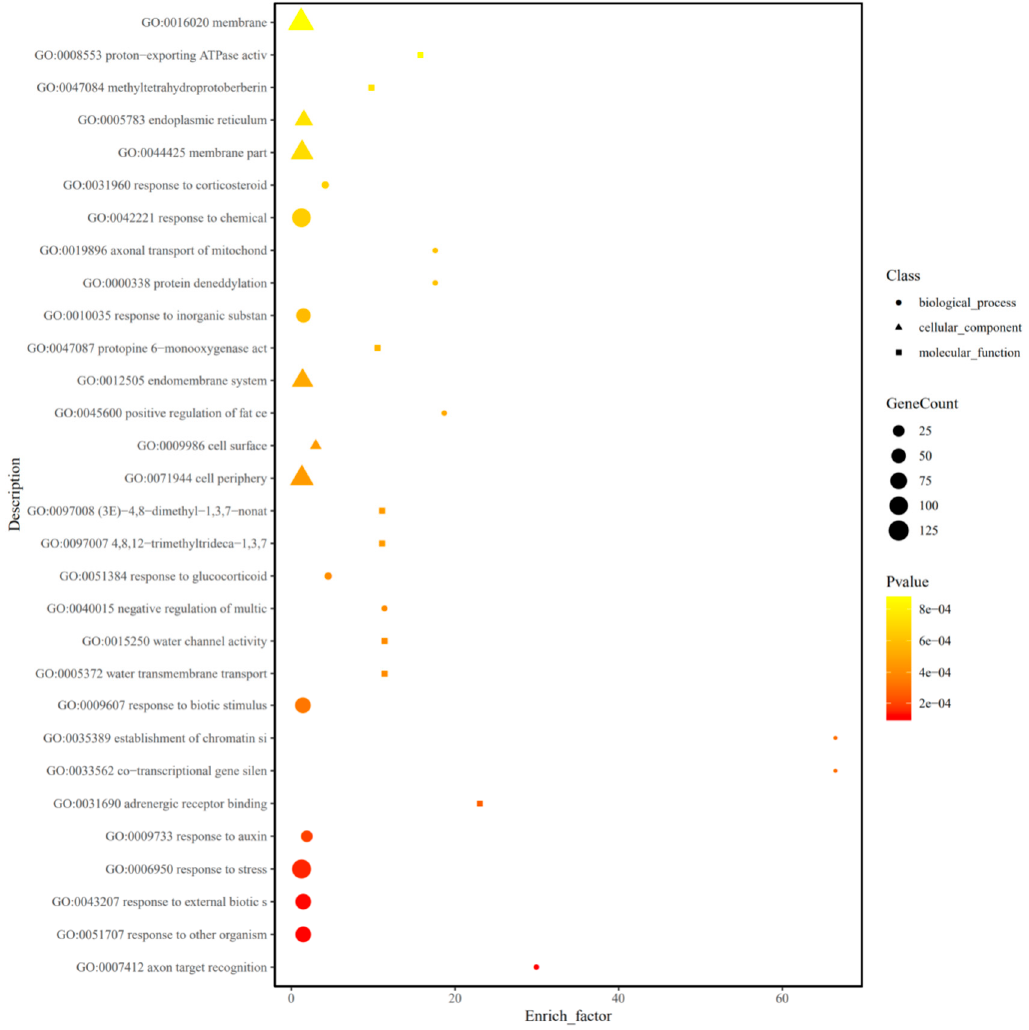
Figure 8. Gene ontology (GO) enrichment analysis on target genes of di ff erentially expressed lncRNAs under boron deficiency stress. The GO analysis and enrichment is measured by enrich factor, P value, and the number of genes enriched on this pathway (Enrich_factor = GeneRatio / BgRatio). The larger the enrich factor, the greater the degree of enrichment. The larger the graph (circle: Biological process; triangle: Molecular function; square: Cellular component), the greater the number of di ff erentially expressed genes. The darker the color, the more significant the enrichment of the GO term.